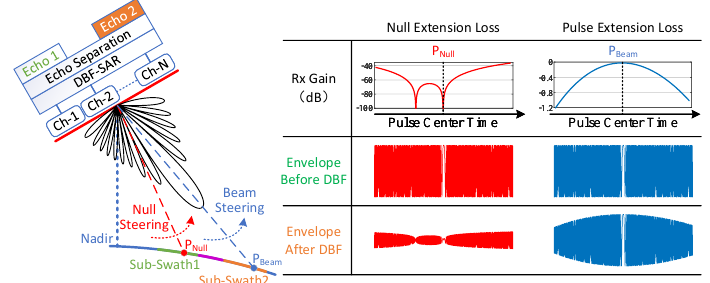
Figure 4. Diagram of the PEL and the NEL